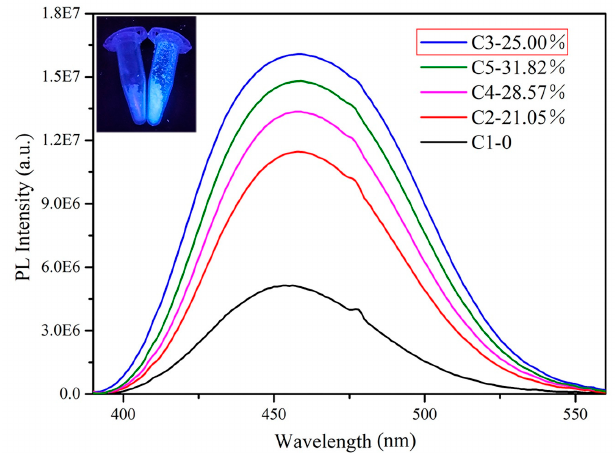
Figure 7. The PL spectra of Cs 2 SnCl 6 crystals with different Ce doping concentrations, the picture of sample C1 and C3 under ultraviolet light in the illustration.